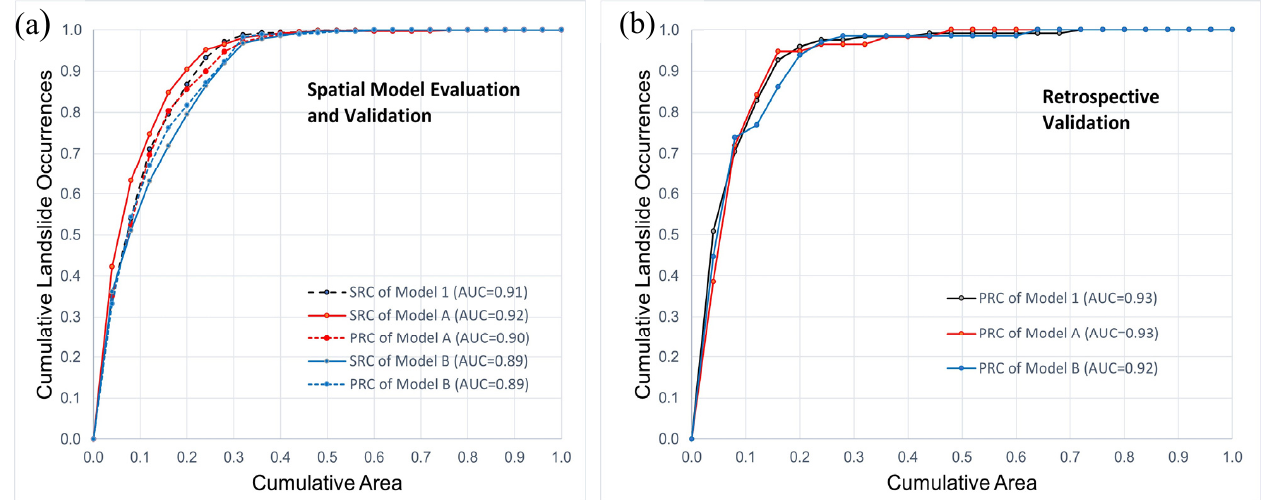
Figure 5. ( a ) ROC curves of spatial model evaluation and validation with associated AUC values for model 1, model A, and model B. ( b ) ROC curves of retrospective validation with associated AUC values for the same models.